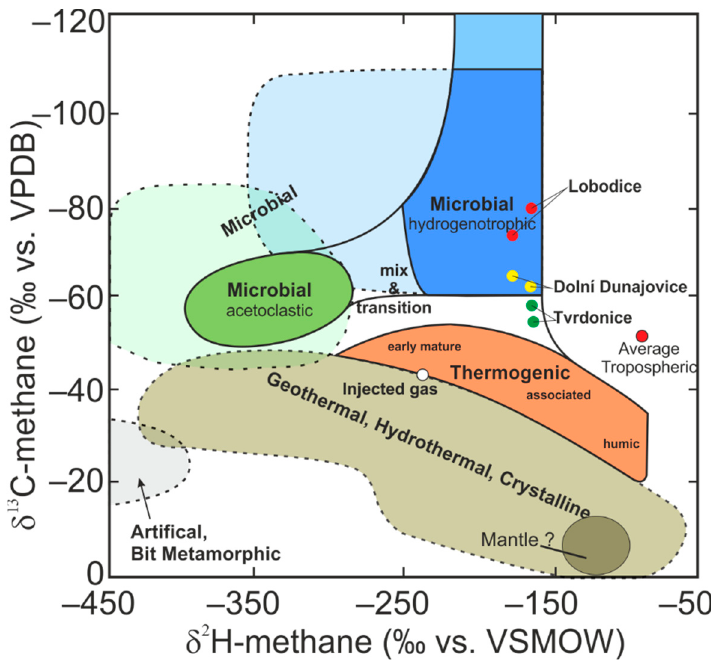
Figure 1. C–D plot [ 42 ] with measured data.